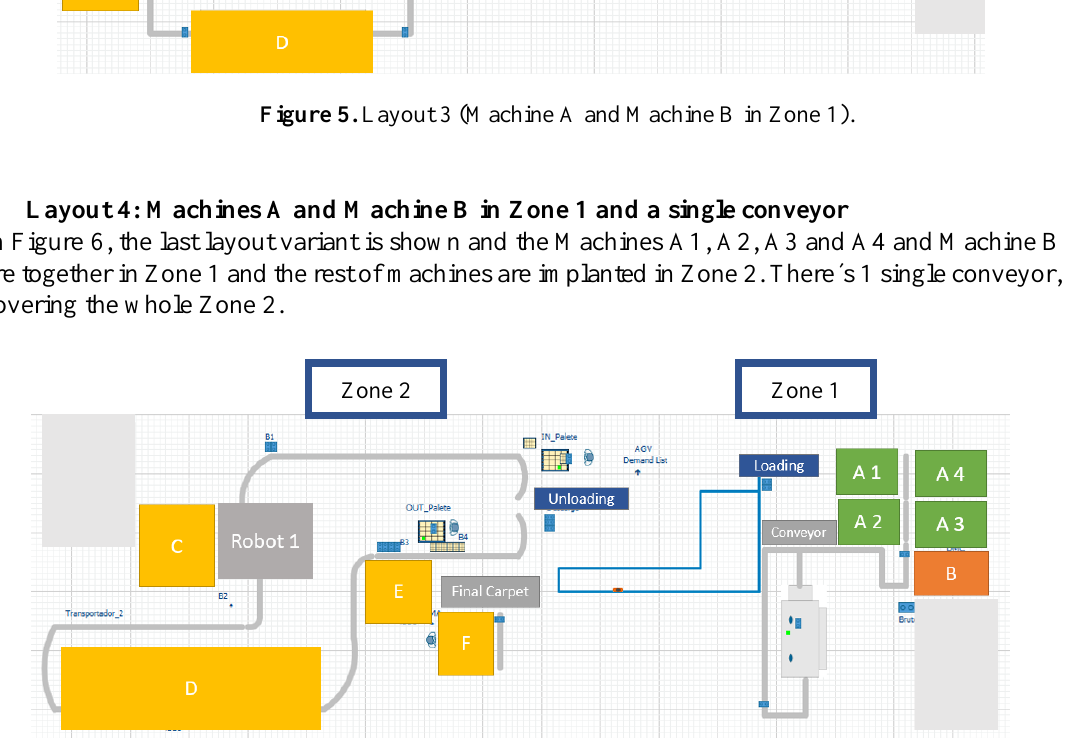
Figure 6. Layout 4 (Machine A and Machine B in Zone 1 and a single